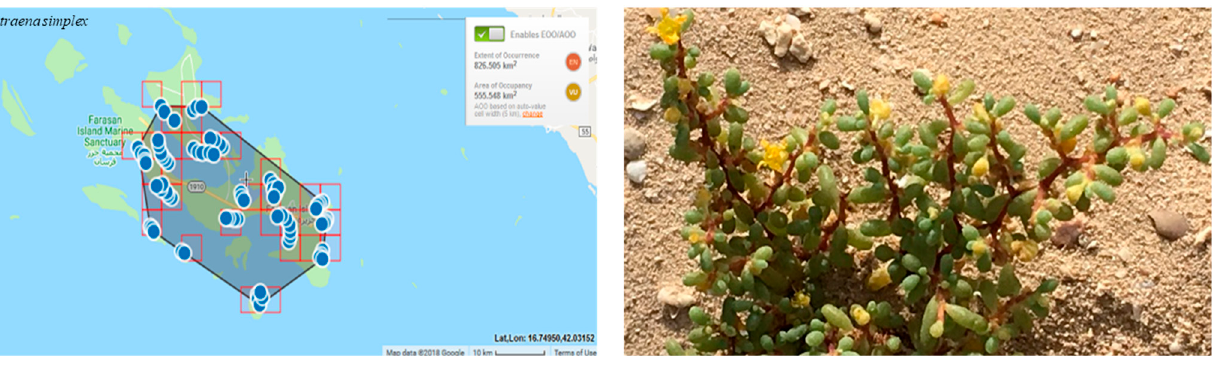
Figure 5. Geographical distribution of Tetraena simplex in the Farasan Archipelago (plant photo by R. Al-Qthanin from Faranan Alkabir Island)